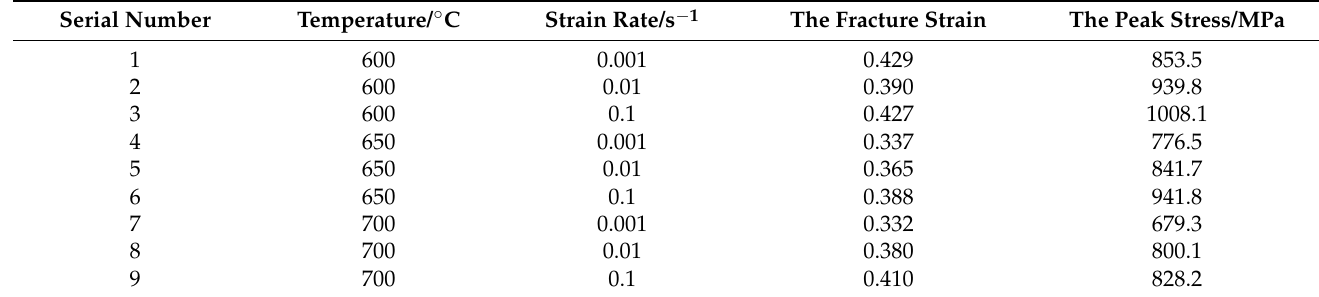
Figure 3. Samples after tension tests. Table 4. Test scheme, the fracture strain, and the peak stress by tensile tests.